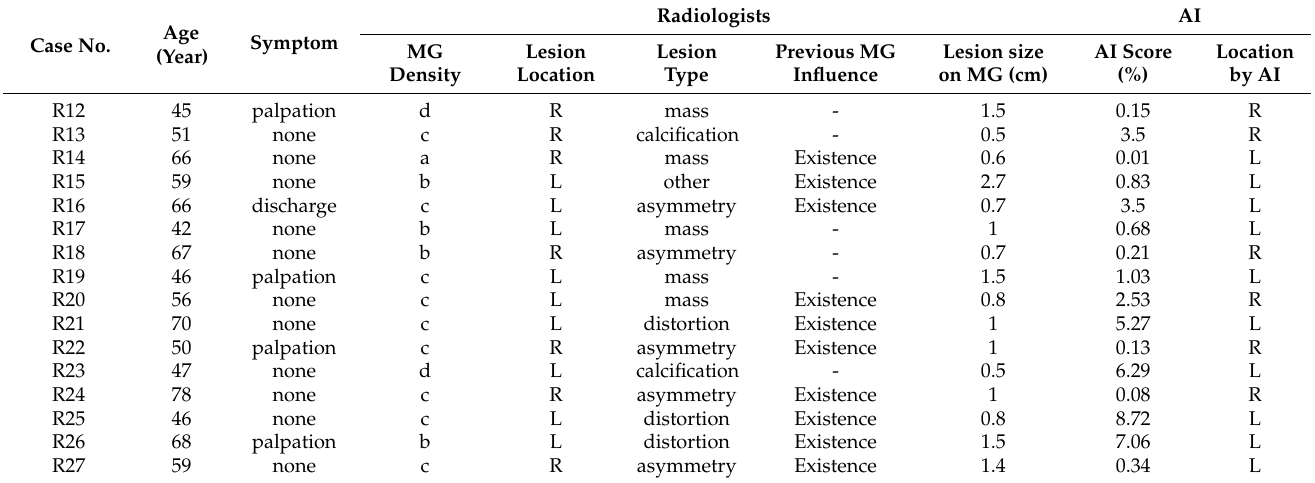
Table 7. Invisible cases in radiologist and concordant cases only in AI analysis.